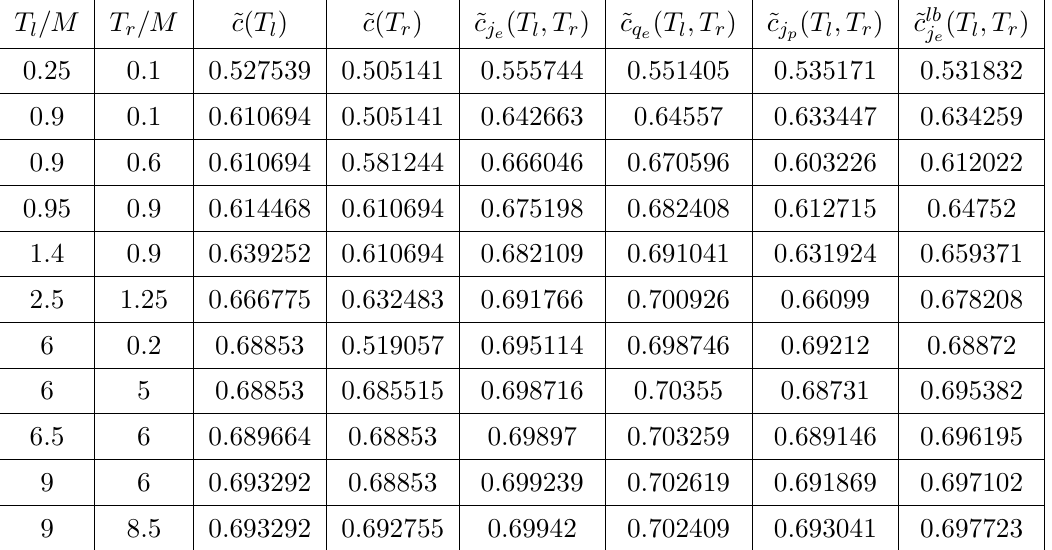
Table 1. The e(cid:11)ective central charges for (left and right) thermal states and the dynamical central charges for the partitioning protocol for various left and right temperatures in the A 2 massless (cid:13)ow, where c UV = 0 : 7 and c IR = 0 :